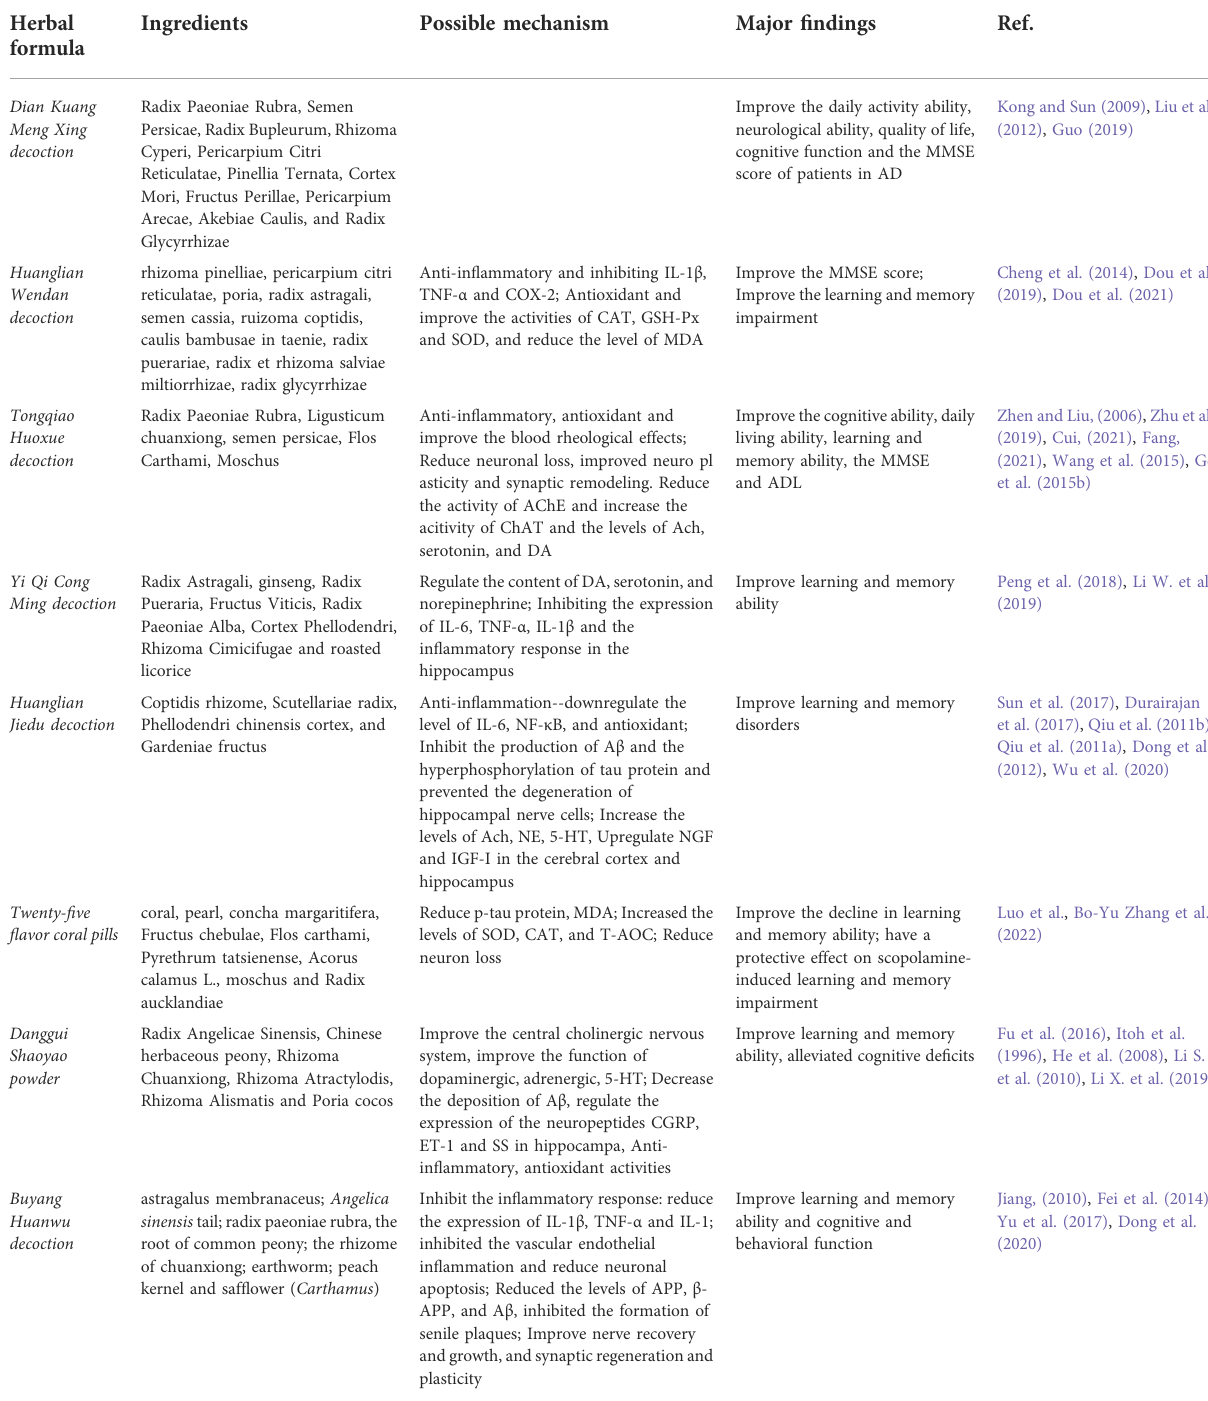
TABLE 1 Treatment of Alzheimer ’ s disease with TCM